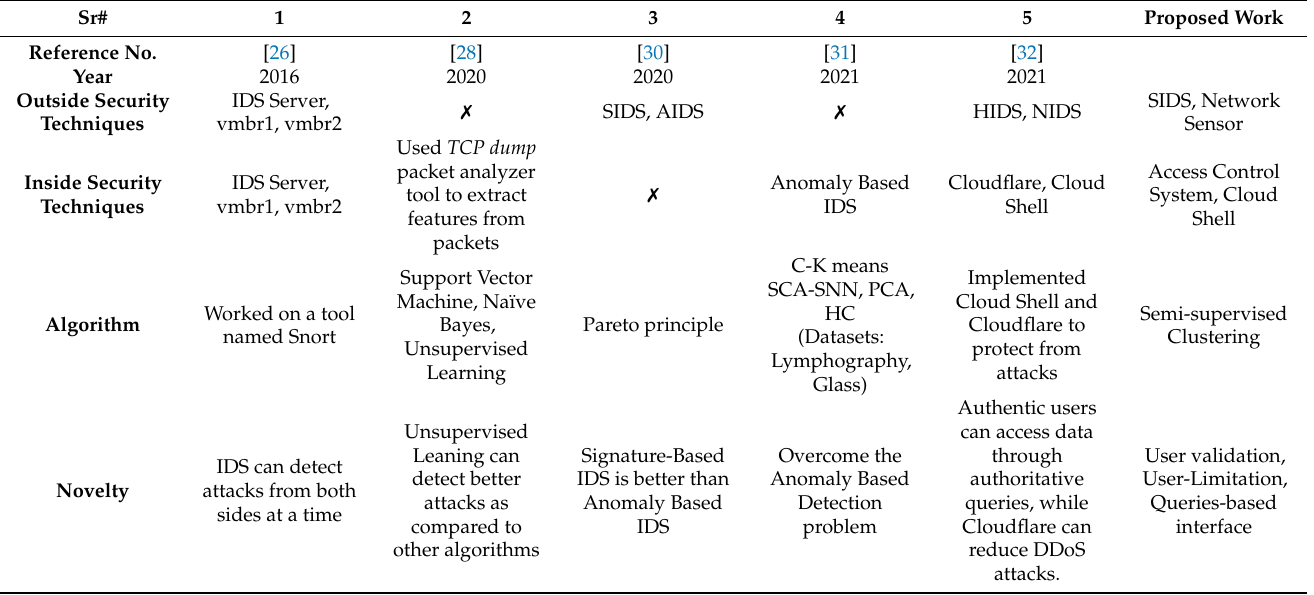
Table 4. Comparative analysis of